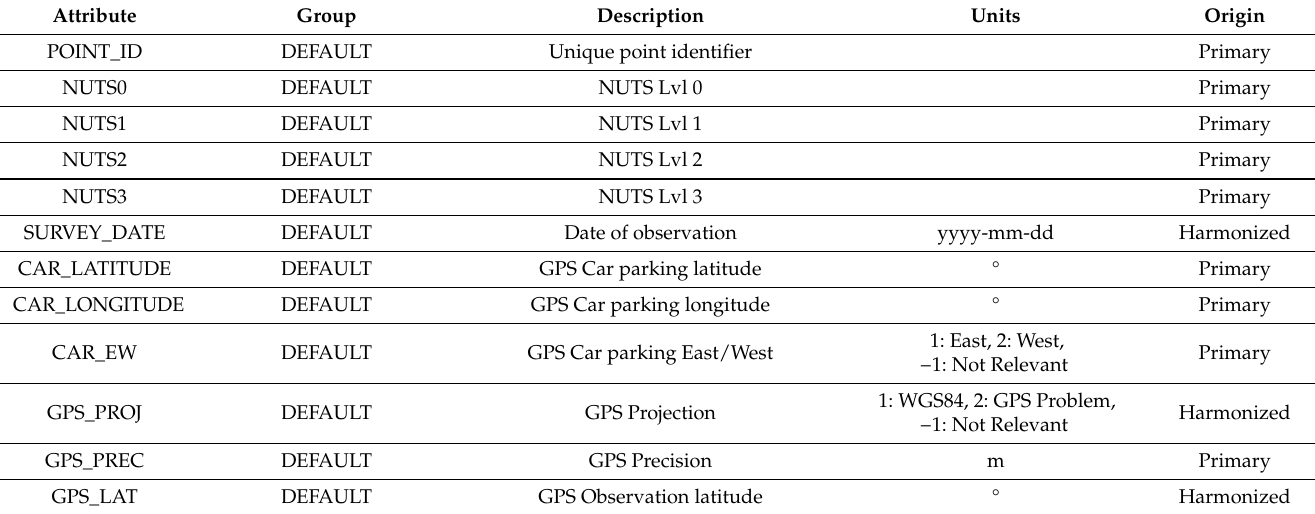
Table A2. List of ST_LUCAS